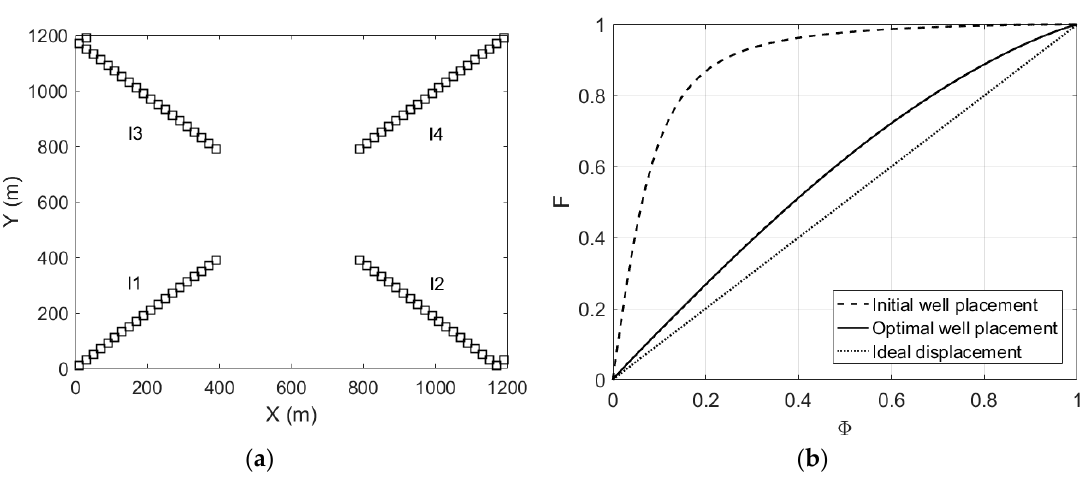
Figure 4. The results of the two-dimensional homogeneous aquifer test problem: ( a ) moving positions of the injection wells during the S/O iterations. ( b ) F ( Φ ) diagrams for the initial and optimal well